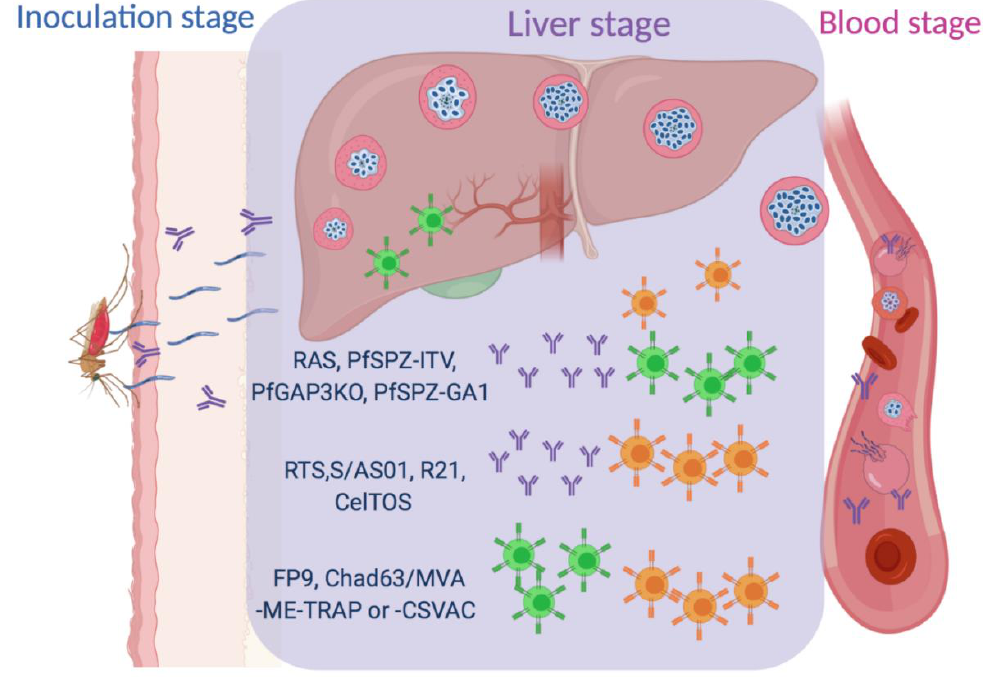
Figure 1. Plasmodium parasites are transmitted by infected Anopheles mosquitos when they draw a blood-meal from the vertebrate host, and concurrently inoculate the sporozoite stage of the parasite into the skin (inoculation stage). The motile sporozoites exit the dermis and enter the blood stream, travel to the liver and establish an infection in the hepatocytes (liver-stage). The sporozoites undergo asexual replication in the hepatocytes before budding off as hepatocyte plasma membrane-bound merosomes containing infective merozoites into the bloodstream, concluding the pre-erythocytic stage of malaria in the vertebrate hosts. Merosome rupture in the blood vessels to release the merozoites that invade red blood cells, to initiate the blood stage of malaria. Effective pre-erythrocytic-stage vaccines against malaria prevent the invasion and development of Plasmodium in the liver. While the RTS,S/AS01, R21 and CelTOS vaccines rely on the antibody and CD4 (orange) T cell responses generated against the constituent Plasmodium subunit antigens, the radiation-attenuated sporozoites (RAS), Pf SPZ-ITV, Pf GAP3KO and the Pf SPZ-GA1 vaccines generate protective antibody, CD4 and CD8 (green) T cell responses against multiple Plasmodium antigens. The FP9, ChAd63/MVA-ME-TRAP or -CSVAC vaccines rely on the activation of both CD8 and CD4 T cell responses.